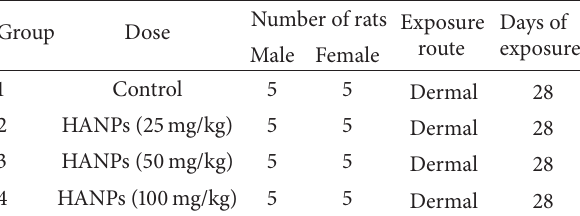
Table 1: Experimental